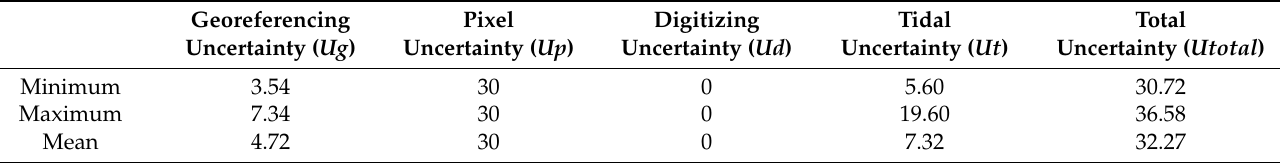
Table 1. Summary statistics of different parameters used in shoreline uncertainty